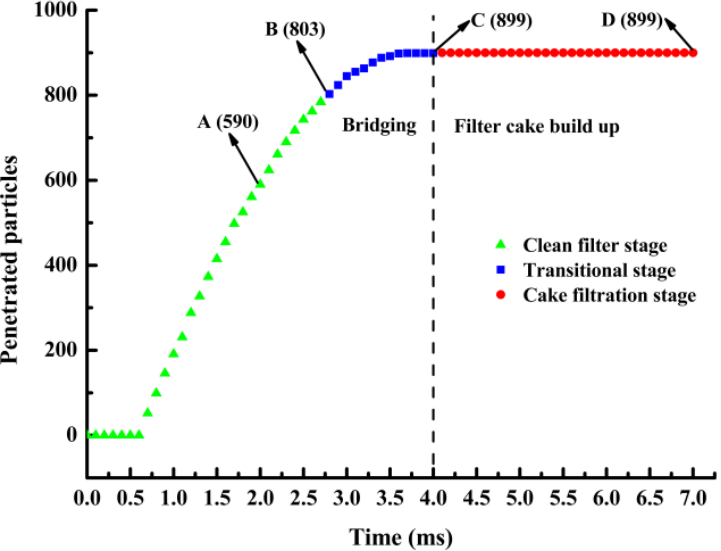
Figure 5. Curve of cumulative number of particles passing through with time.